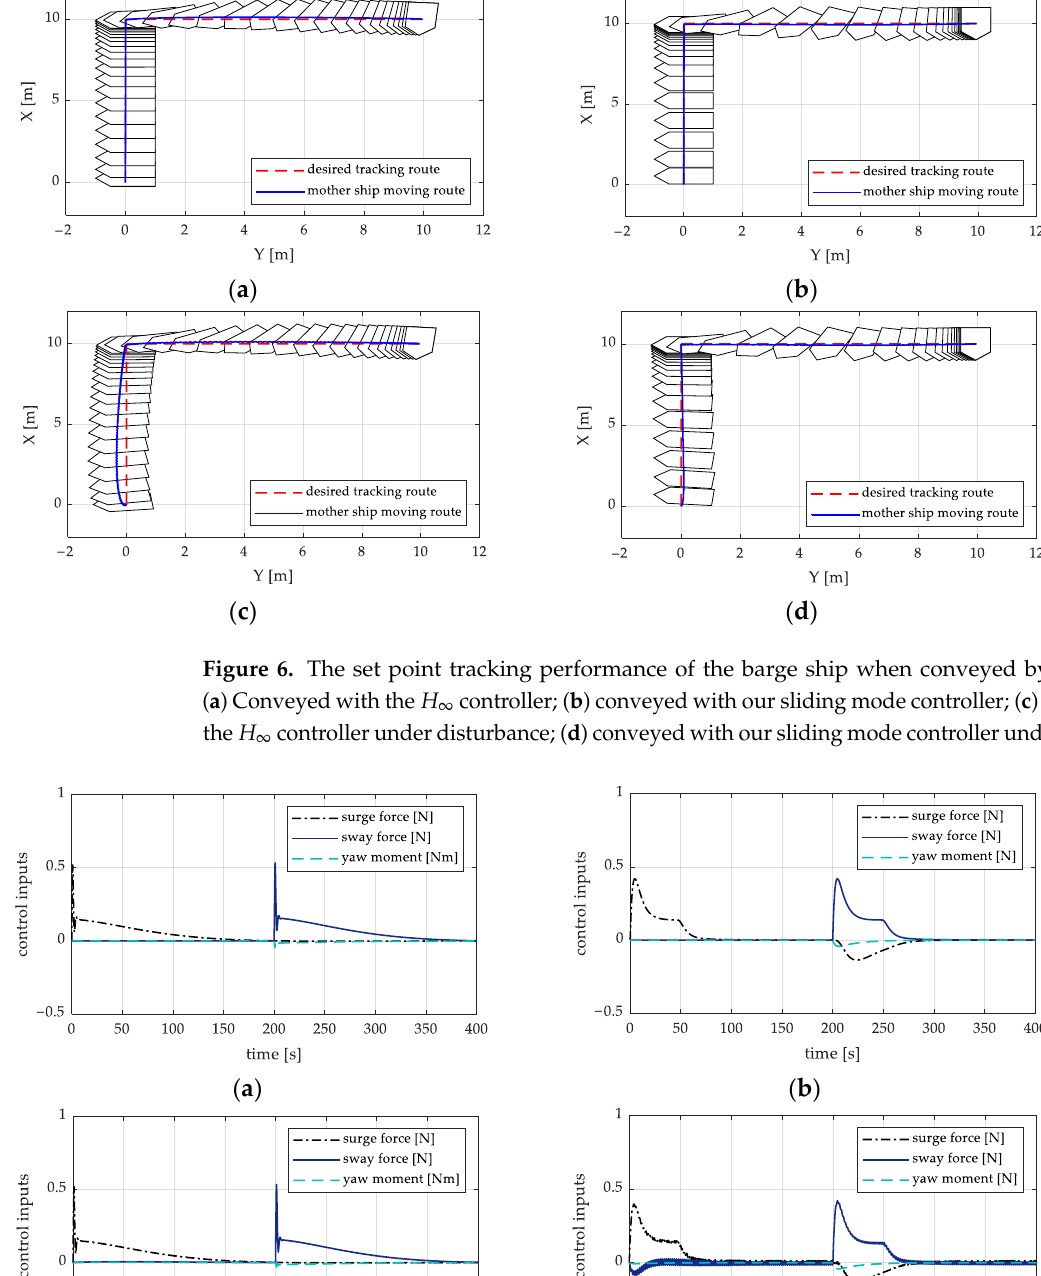
H controller; ( b ) conveyed H controller under disturbance; ( d ) con-